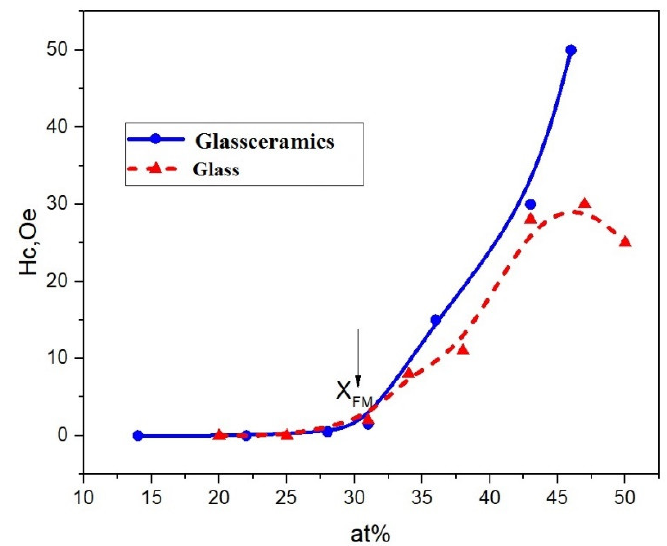
Figure 9. Dependences of the coercive force H c on the concentration of metal alloys in nanocomposites (CoFeZr) x (MgF 2 ) 100 − x on glass-ceramics and glass substrates. Comparison of the spectral dependences of the TKE for nanocomposites on different substrates also shows their significant differences (Figure 10).